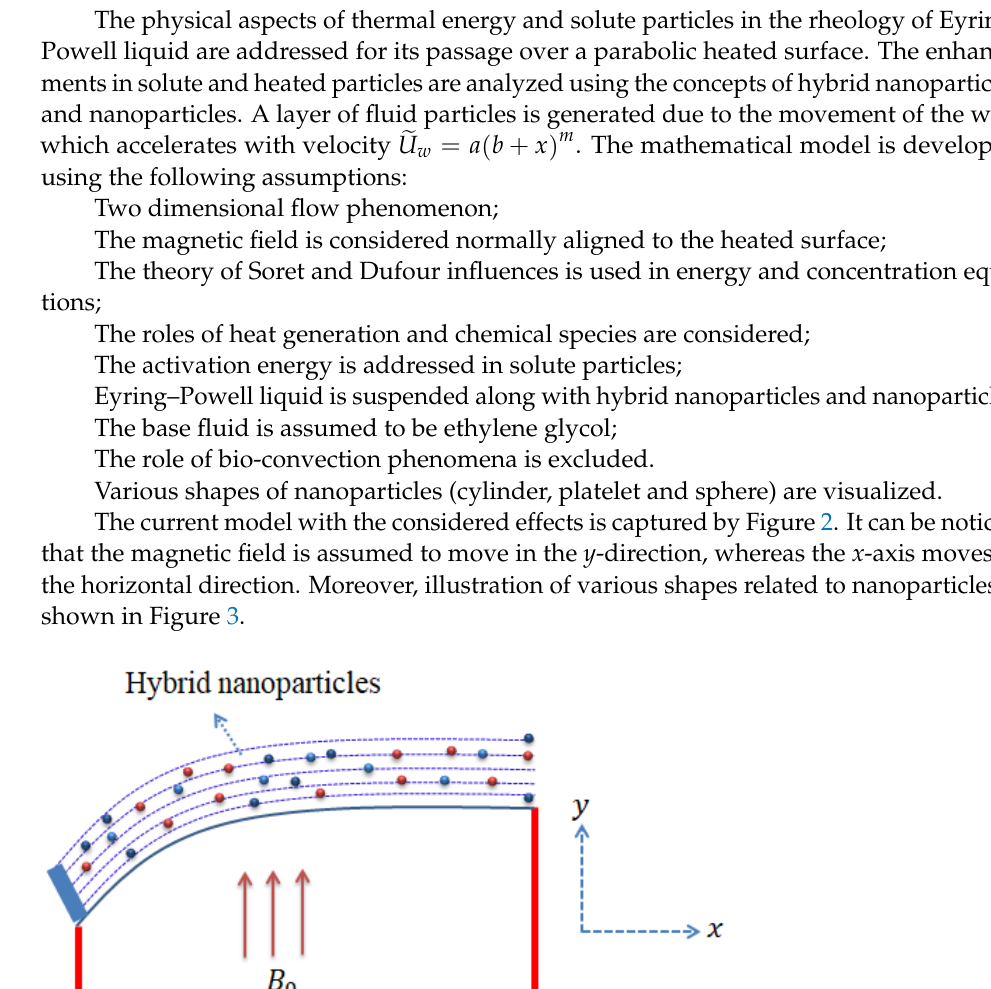
Figure 1. The view of hybrid nanoparticles and nanoparticles in base fluids.